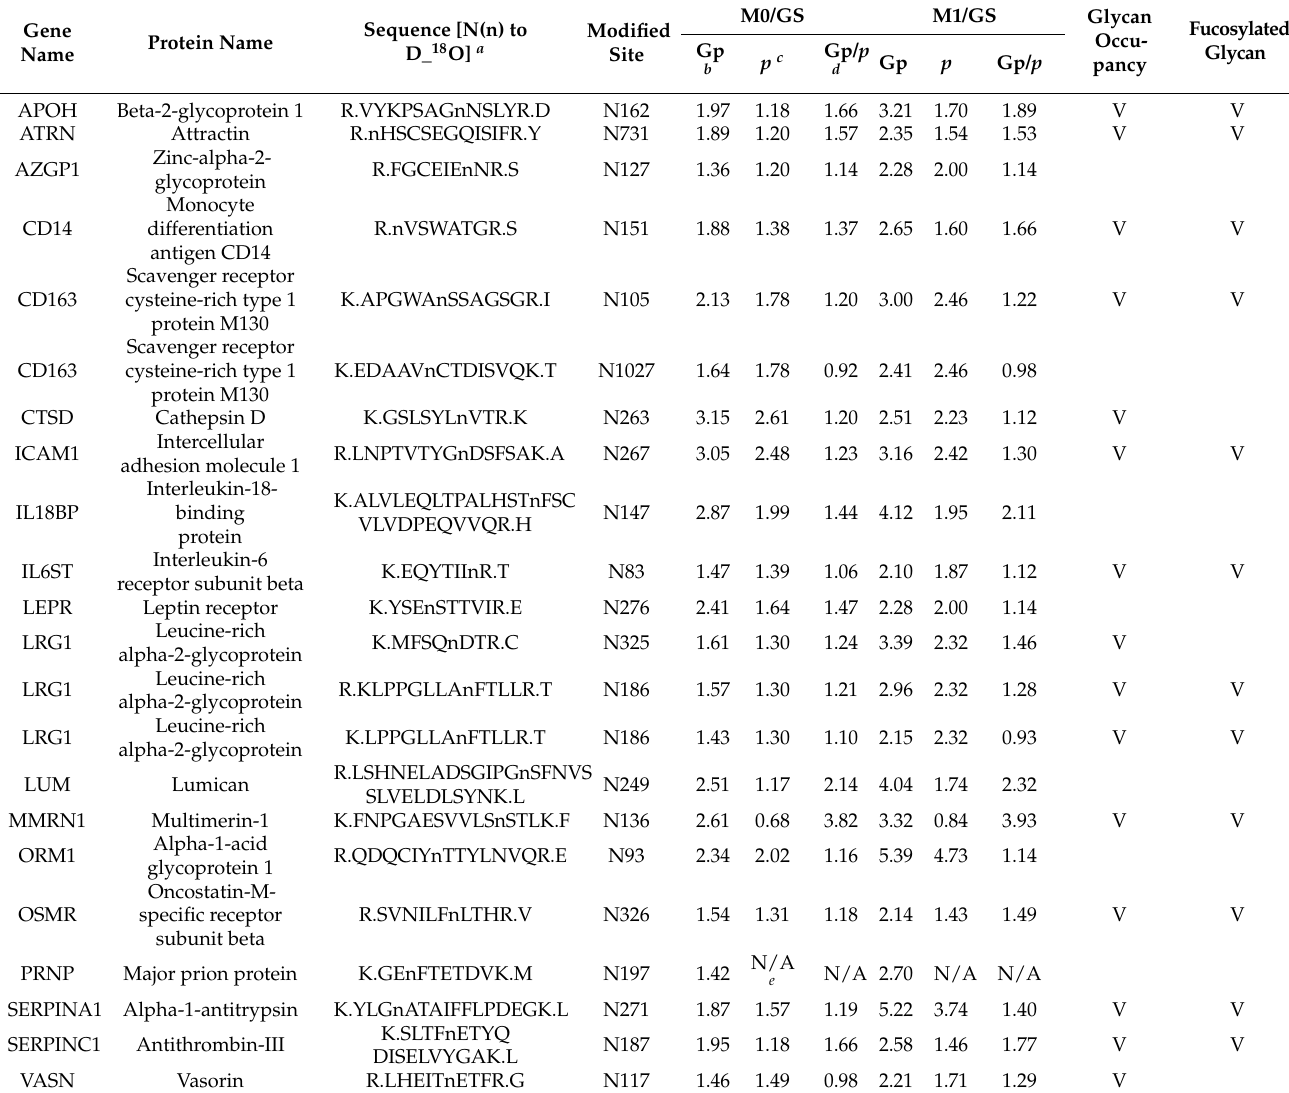
Table 3. List of 22 glycopeptides showing significantly elevated levels in plasma samples of PC patients compared to GS